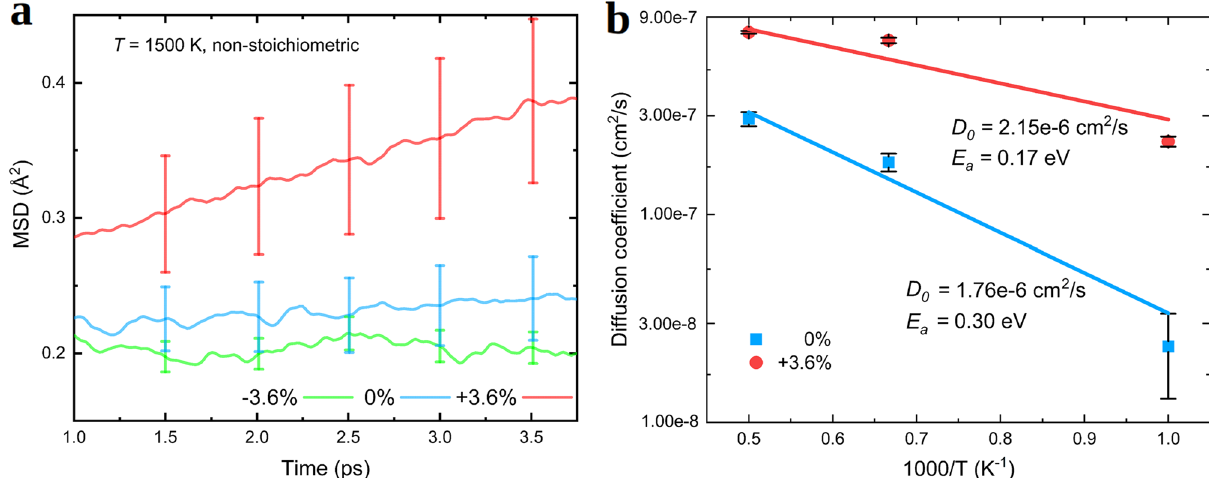
Figure 7. ( a ) Mean square displacement (MSD) calculated for oxygen ions in off-stoichiometric (001) STO thin films with AIMD simulations performed at T = 1500 K and considering different epitaxial strain conditions, namely, η = − 3.6 , 0 and + 3.6 %. ( b ) Oxygen diffusion coefficients estimated for off-stoichiometric (001) STO thin films with AIMD simulations considering different temperatures and epitaxial strain conditions. The resulting pre-exponential factors, D 0 , and activation energies, E a , for oxygen ionic diffusion are indicated in the plot ("Ab initio molecular dynamics simulations"